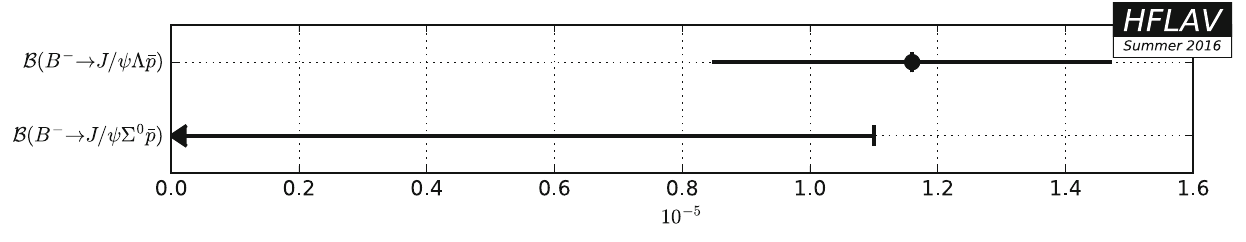
Fig. 135 Summary of the averages from Table